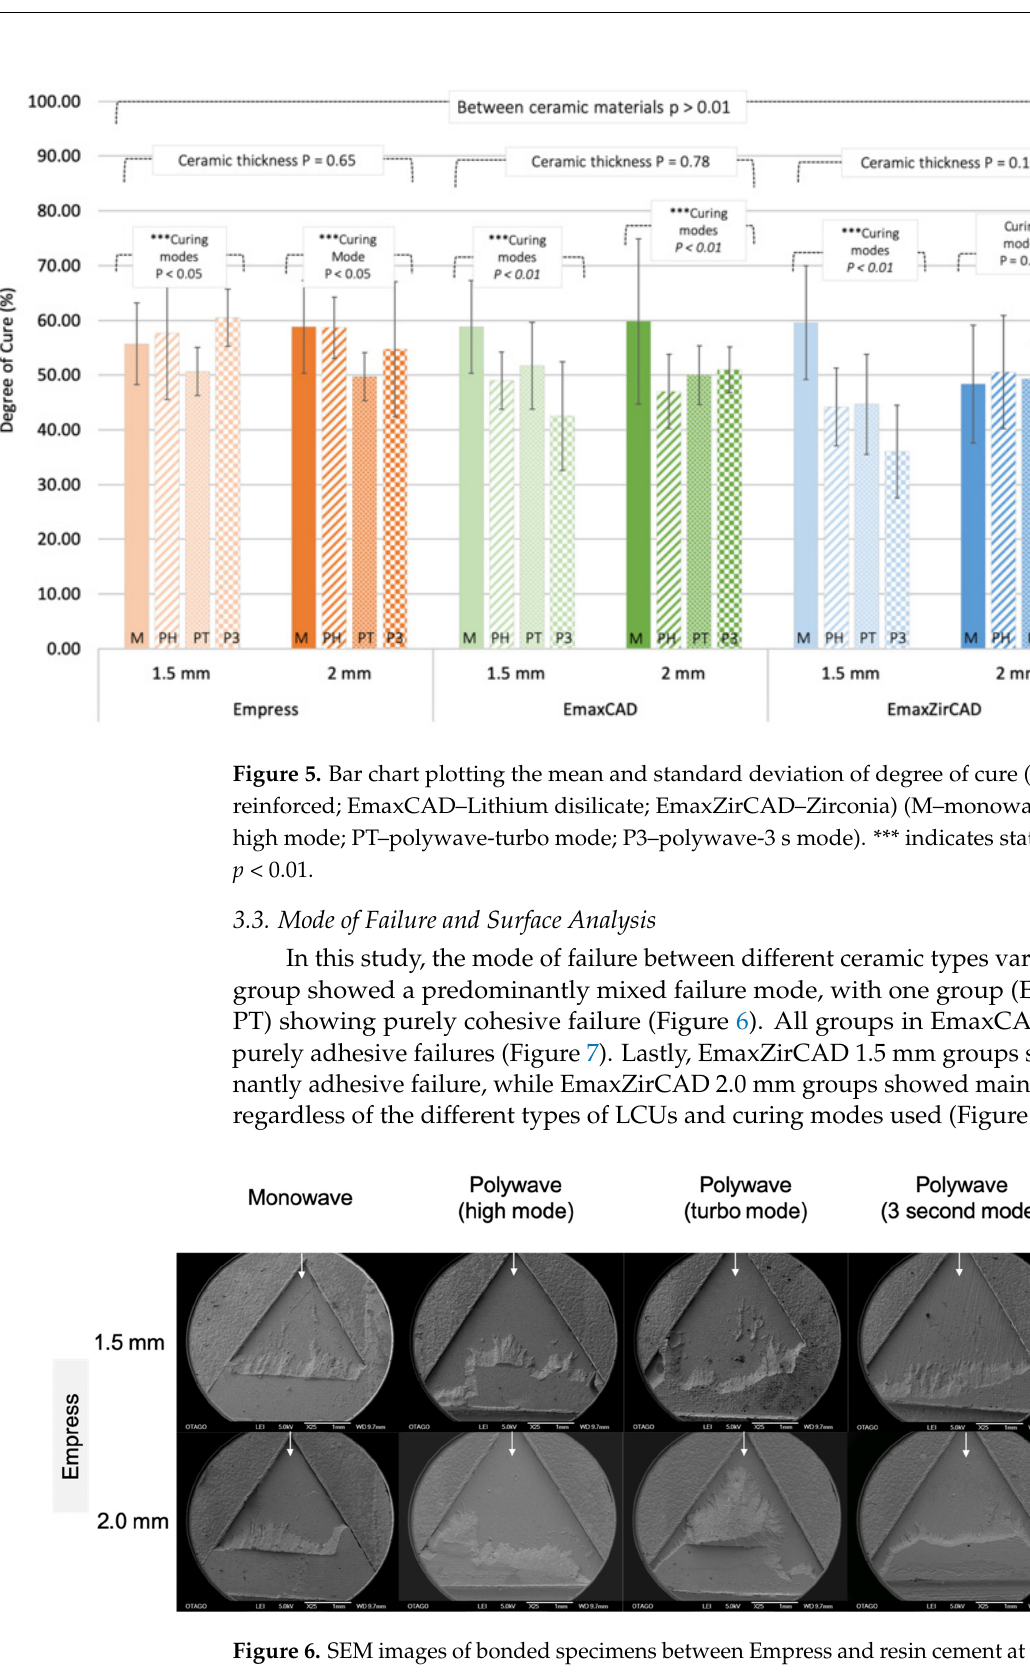
Figure 7. SEM images of bonded specimens between EmaxCAD and resin cement at 25 x magnifi- cation to show overall mode of failure. The arrow is positioned at the tip of the chevron notch and shows the direction of crack propogation.